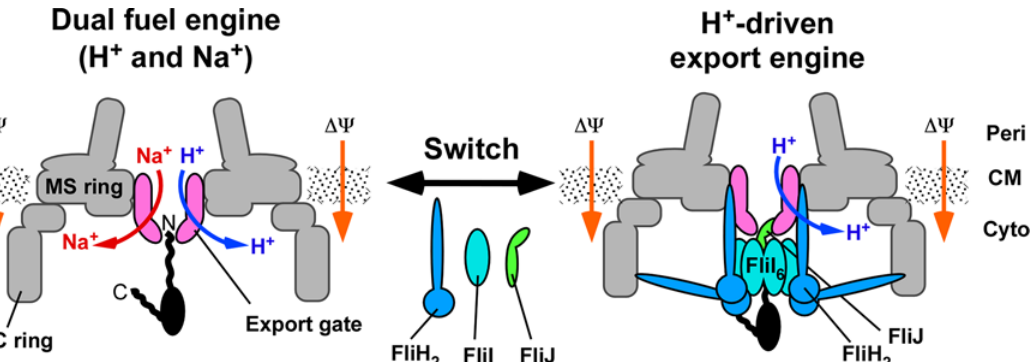
Fig 7. Schematic diagram of the flagellar type III export apparatus. The flagellar export apparatus is composed of a transmembrane export gate complex made of FlhA, FlhB, FliO, FliP, FliQ and FliR and a cytoplasmic ATPase complex consisting of FliH, FliI and FliJ. The export gate acts as a dual fuel H + /Na + – protein antiporter that can use both the H + and Na + gradients to drive flagellar protein export when the cytoplasmic ATPase consisting of FliH, FliI and FliJ cannot work properly due to internal perturbations. A specific interaction between FliJ and FlhA brought about by FliH and FliI switches a much less efficient dual fuel engine into a highly efficient H + -driven export engine. Δψ , membrane voltage; OM, outer membrane; PG, peptidoglycan layer; CM, cytoplasmic membrane.